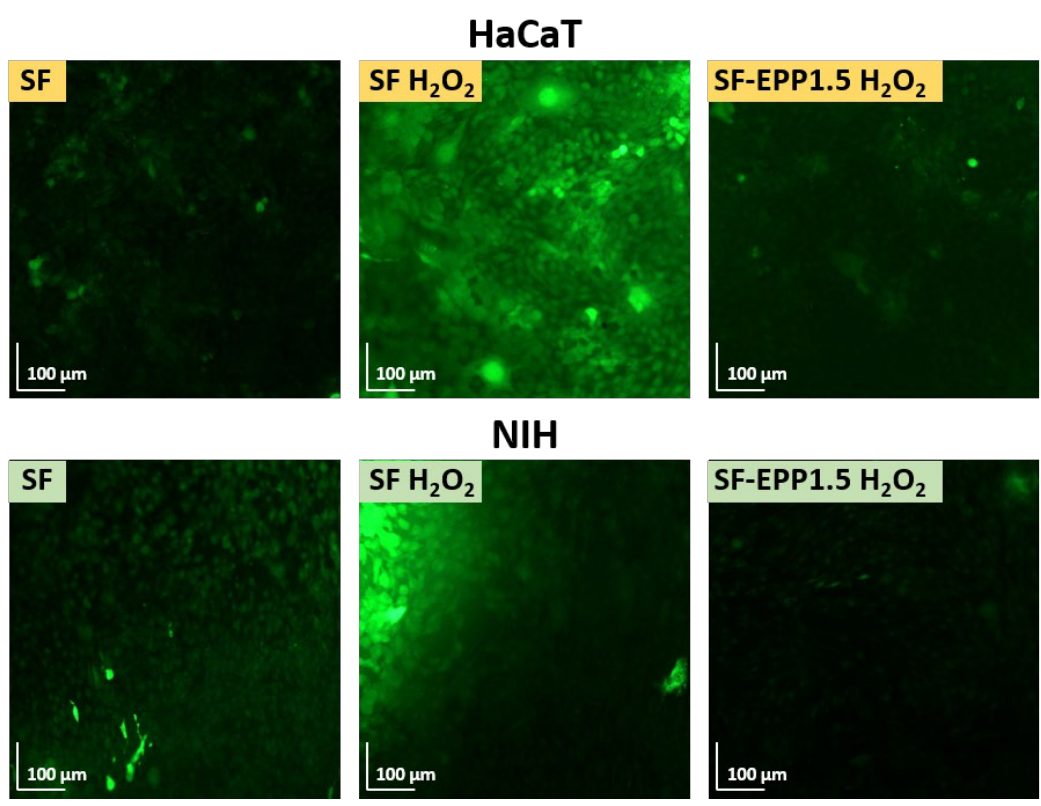
Figure 8. ROS production of HaCaT and NIH cells plated on pristine SF and SF-EPP films before and after treatment with H 2 O 2 . Magnification: 10×, scale bar: 100 μm.